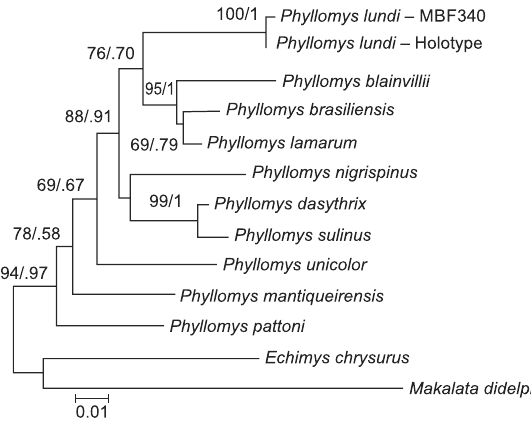
Figure 3. Maximum likelihood topology based on cytochrome b sequences. Numbers near branches are bootstrap values ≥ 70 for ML (above) and posterior probabilities for BI